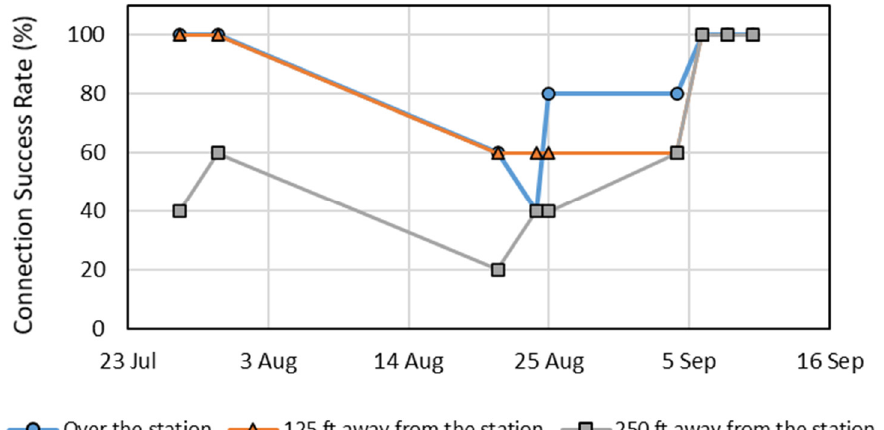
Figure 7. The CSR (in %) for the five replications of secondary radios communicating with the primary radio mounted on the UAS for three treatments during the 2021 growing season. The UAS maneuvered at a height of 31 m above the ground at a lateral distance of: (i) 0 m from (over) the sensor node station; (ii) 38 m from the sensor node station; and (iii) 76 m from the sensor node station.